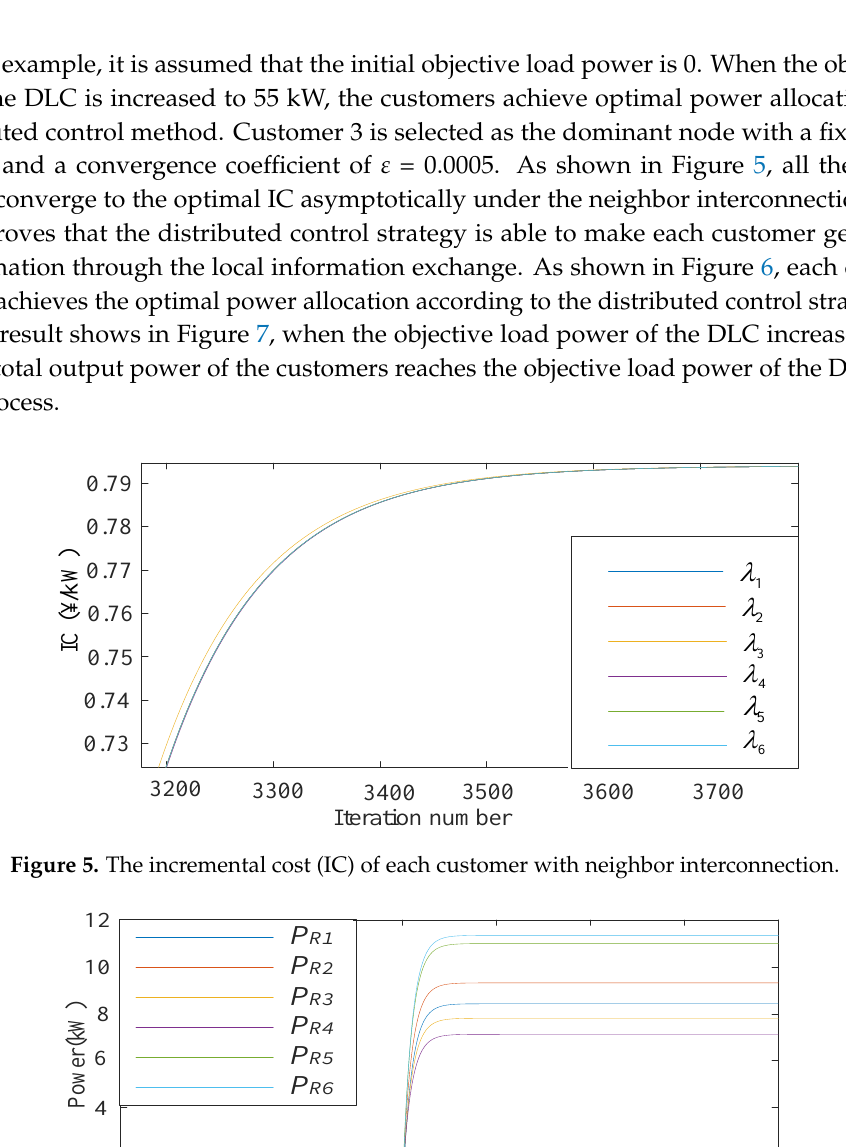
Figure 4. The fitting function plot of Customer 3.